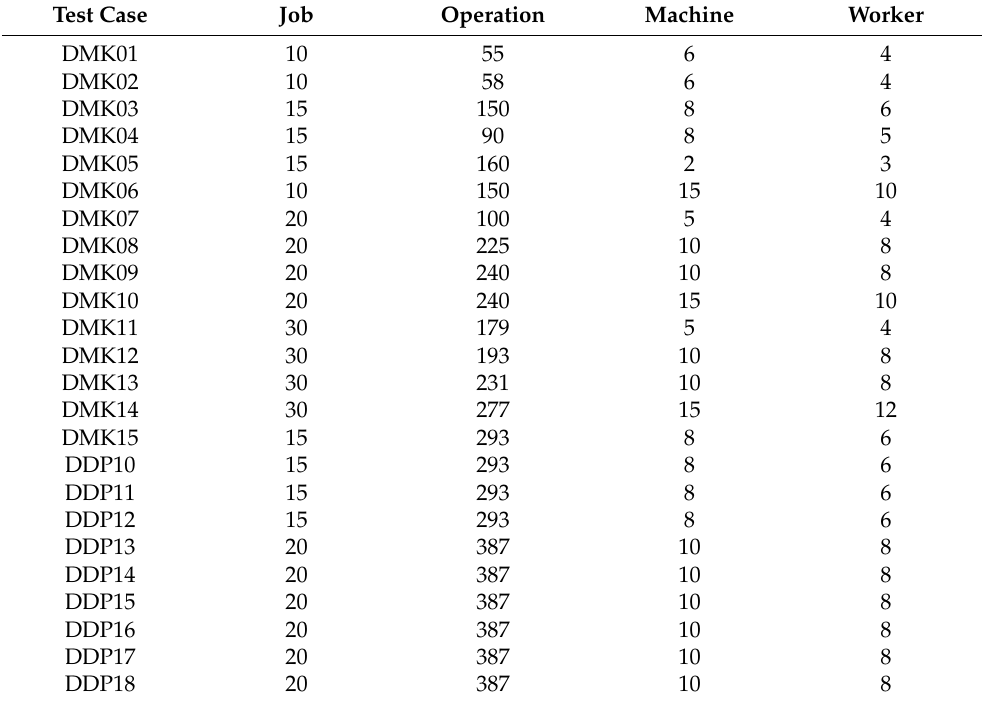
Table 2. Scale of the test case.